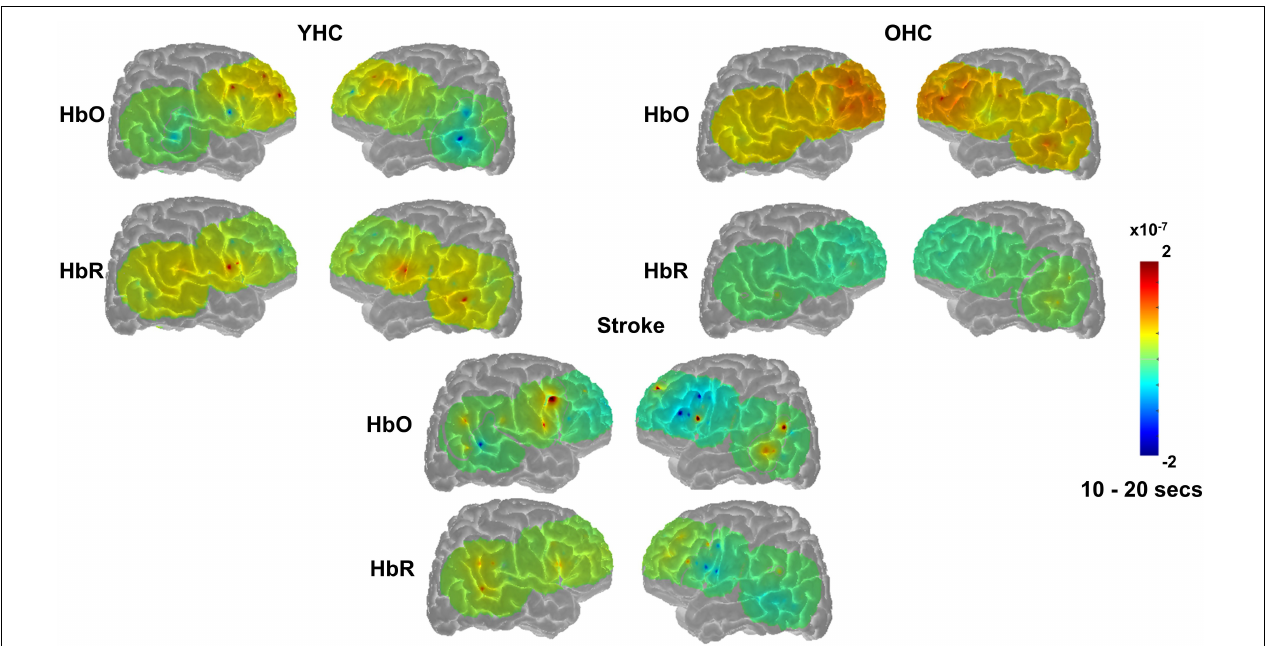
FIGURE 12 | Group mean HRF concentration overlays displaying the hard minus easy addition contrast during the arithmetic task. The color bar reflects the scale of the concentration change in µ M units. HbO, oxygenated hemoglobin concentration change; HbR, deoxygenated hemoglobin concentration change; YHC, younger healthy controls; OHC, older healthy